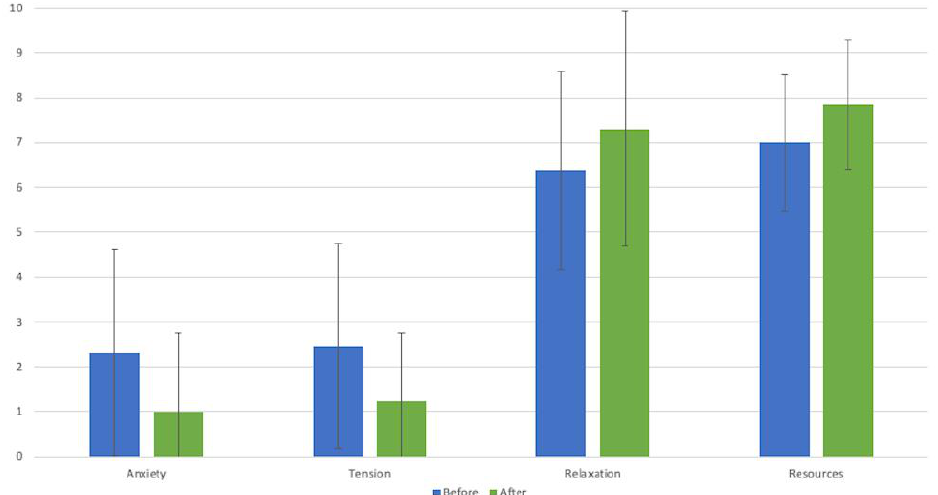
Figure 3. CSOM results. Bars indicate the means of subjective evaluations of experienced mental states before and after the VR intervention.